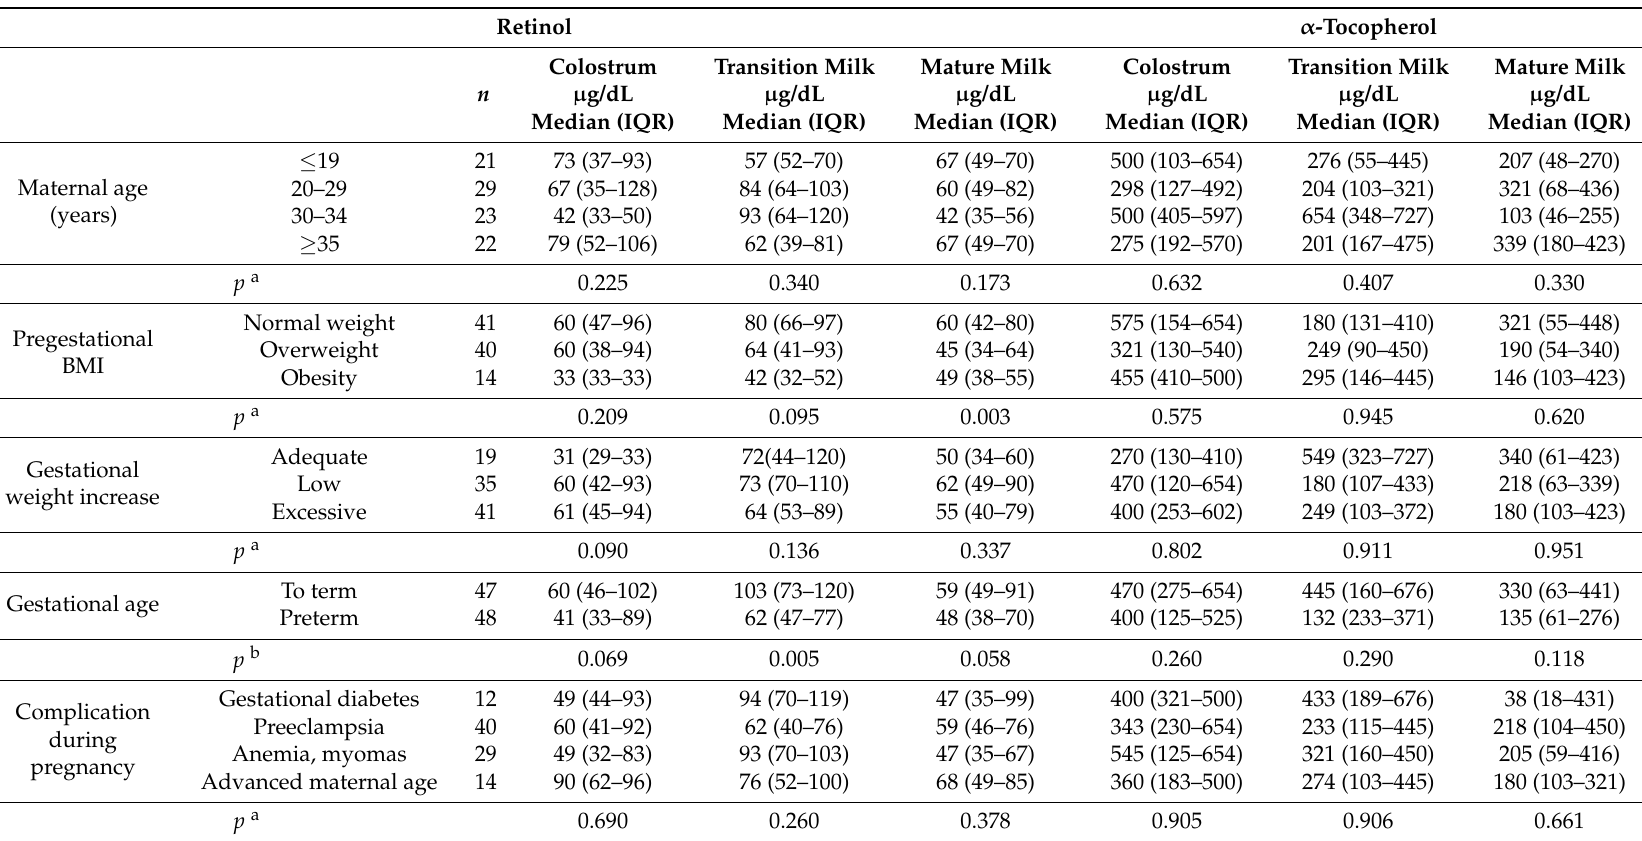
Table 2. Concentrations of retinol and α -tocopherol in breast milk, in relation to some perinatal data of the women with a high-risk pregnancy ( n =